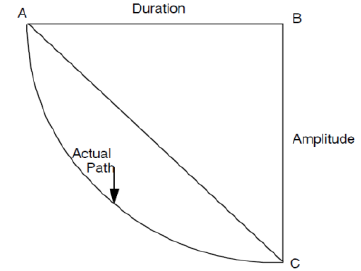
Figure 6. Schematic presentation of cycle and